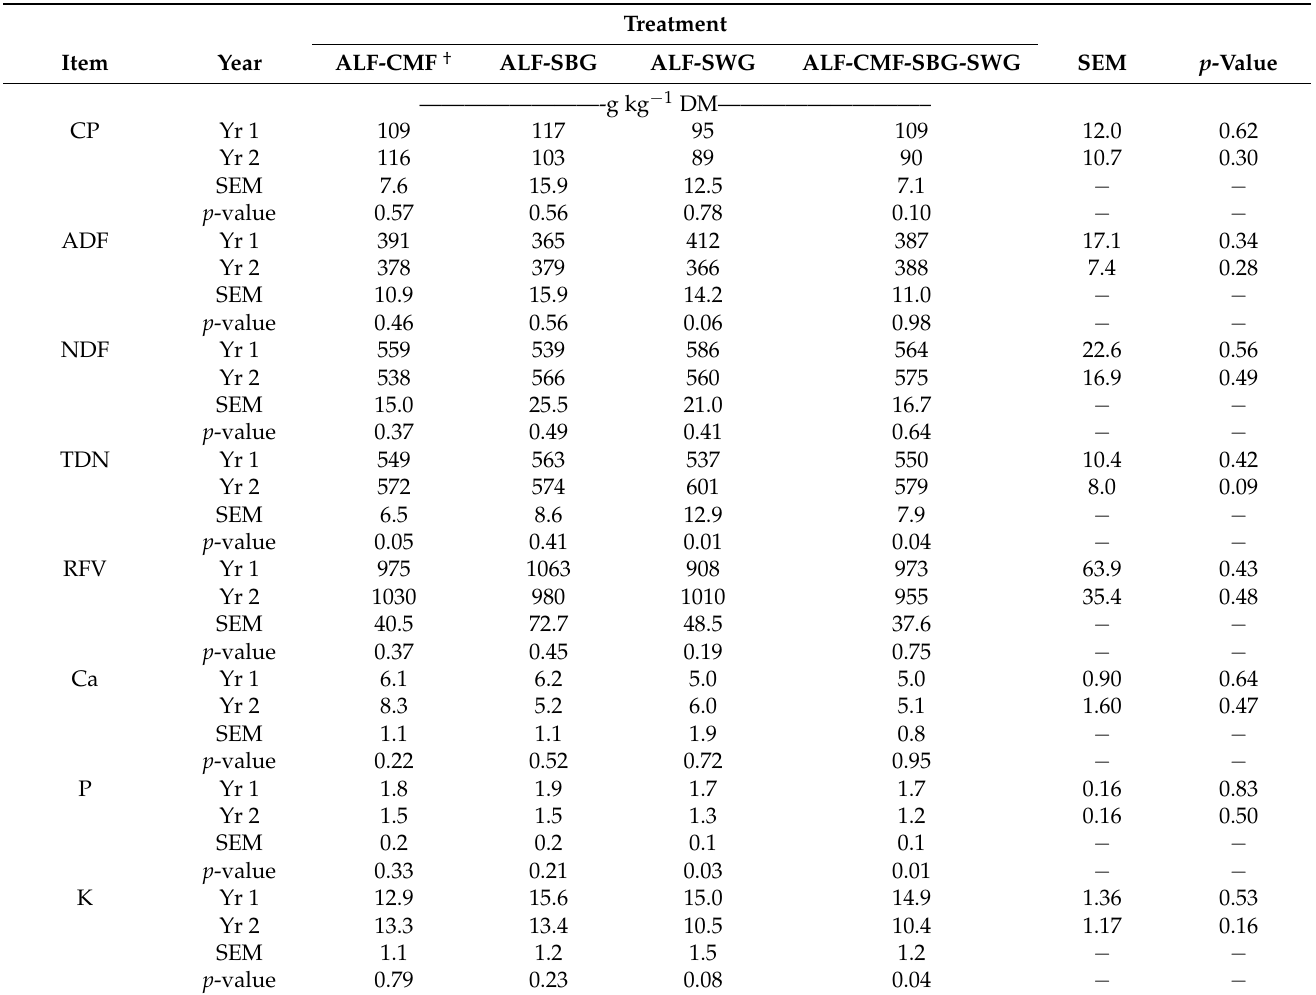
Table 5. Nutrient composition of ‘Halo’ alfalfa and grass mixtures in Clavet, Saskatchewan, Canada over 2 yrs (2020–2021).